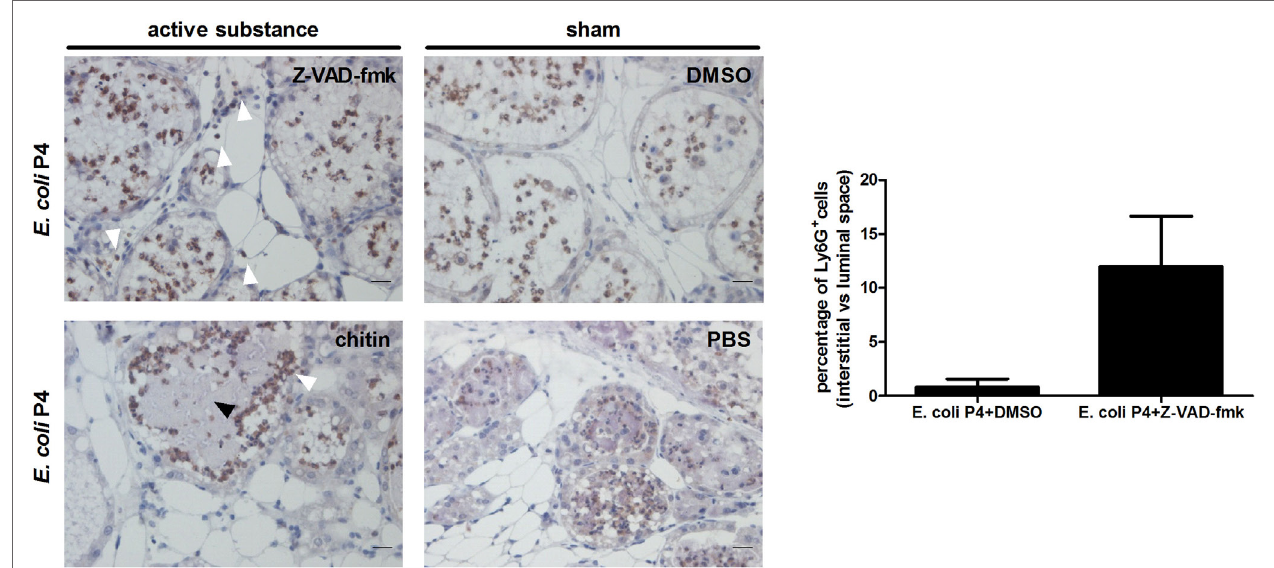
FigUre 5 | Ly6G immunohistochemistry in Escherichia coli P4-infected mammary glands posttreatment with active substances or sham controls. Immunohistochemical stainings for Ly6G on paraffin slides of E. coli P4-infected mammary glands treated with Z-VAD-fmk, DMSO, chitin, or phosphate buffered saline (PBS). White arrows indicate Ly6G-positive neutrophils. Black arrows indicate bacterial clusters. Scale bars = 20 μ m. The bar graph displays the quantified percentage of Ly6G-positive cells in the interstitial space versus the luminal space for stained sections of E. coli P4-infected mammary glands treated with DMSO or Z-VAD-fmk ( n = 2 glands). Data are presented as means ±